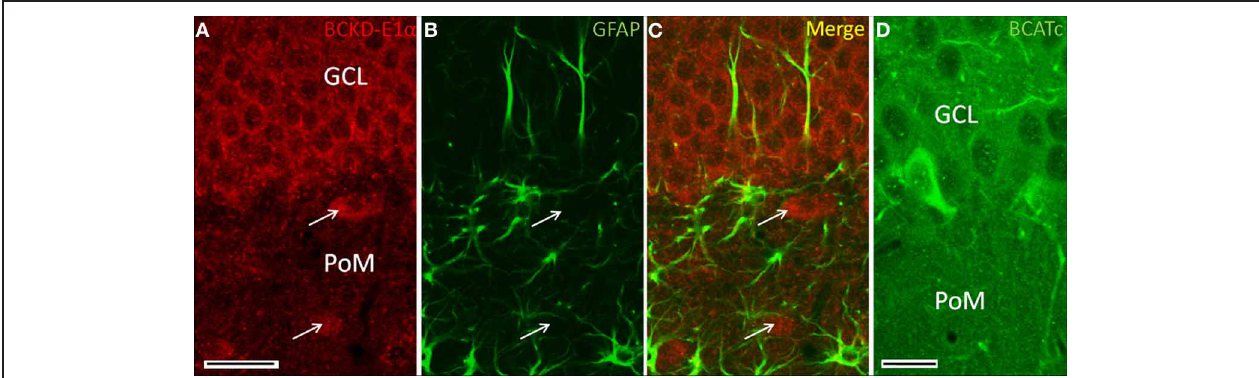
FIGURE 7 | Immunolocalization of BCKDC in dentate gyrus. (A) BCKDC immunolabel is present in neurons of the granule cell layer (GCL). Arrows indicate specific labeling of large neurons of the polymorphic layer (PoM). (B) Immunolabel for the astrocyte marker GFAP in the same section as in panel A . Astrocyte processes are labeled in the granule cell polymorphic layers. Astrocyte cell bodies are also labeled in the polymorphic layer.